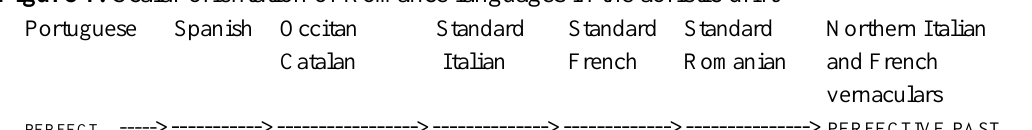
Figure 1: Scalar orientation of Romance languages in the aoristic